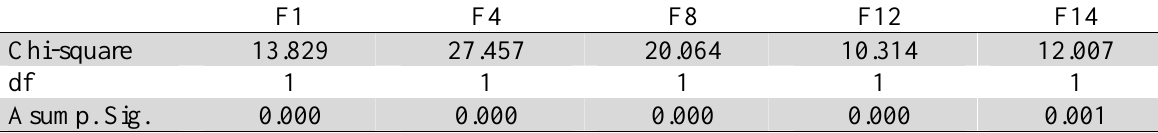
The results of Chi-Square for personal